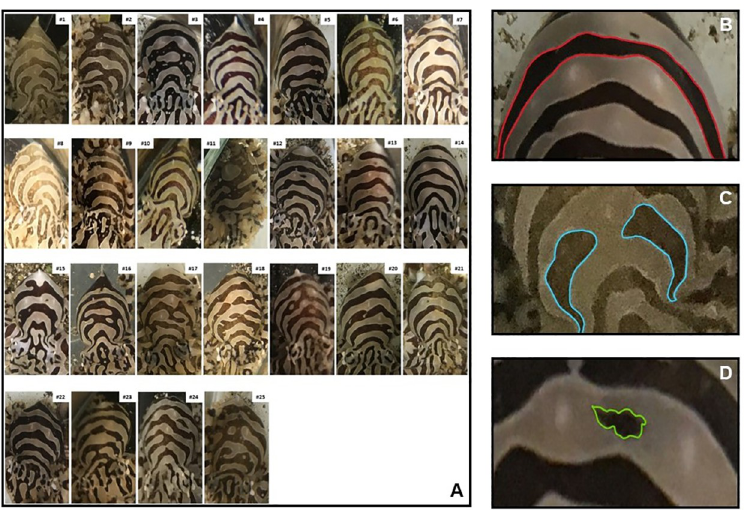
Fig 4. Specific and polymorphic dorsal patterns on mantle of different individuals of O . chierchiae . (A) Side-by- side display of dorsal mantle surface of all O . chierchiae individuals involved in the study. (B) Example of a continuous stripe [red]. (C) Example of a discontinuous stripe [blue]. (D) Example of a spot [green].